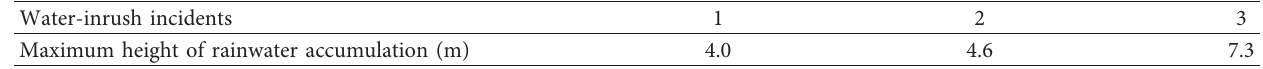
Figure 7: Simulation of the iterative calculation process. Table 4: Results of the iterative calculation on the flooding algorithm.